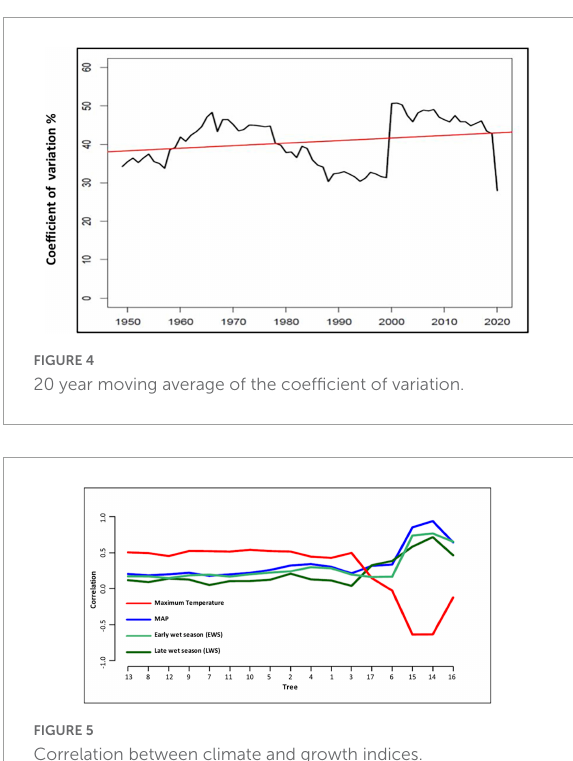
FIGURE5 Correlation between climate and growth